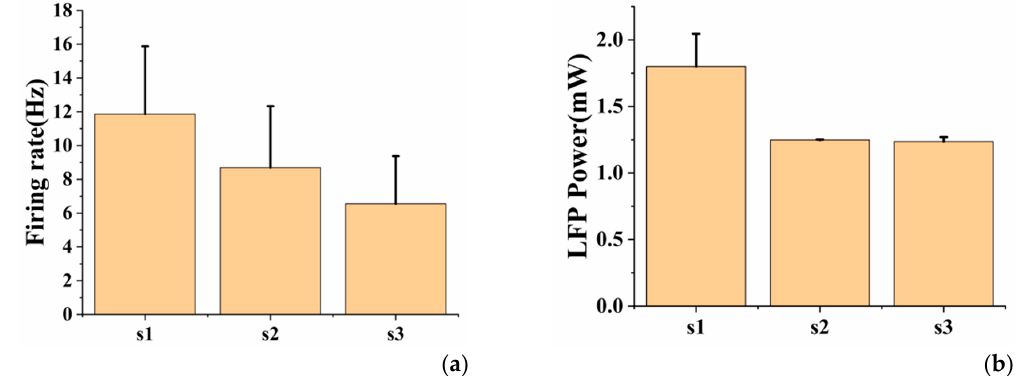
Figure 5. ( a ) The average spike firing rate of neurons under different optical stimulation patterns (s1: 10 Hz, duty ratio=50%, 2 min; s2: 10 Hz, duty ratio=25%, 2 min; s3: 16.6 Hz, duty ratio=25%, 2 min); ( b ) The mean LFP power (0–8 Hz) of neurons under different optical stimulation patterns. Error bars indicate standard deviation of 3 channels.